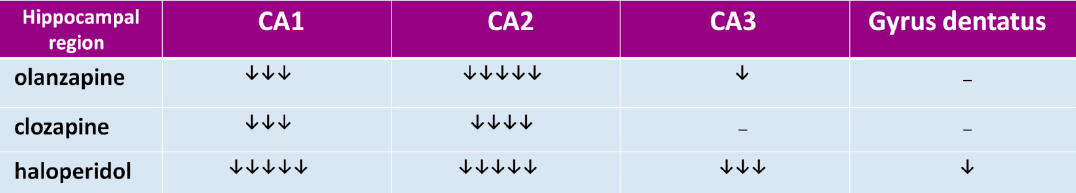
Figure 3. The influence of chronic antipsychotic drug administration on glutamatergic activity in CA1, CA2, and CA3 hippocampus regions and in gyrus dentatus in rats. A number of arrows indicate the neuroleptic’s potential to decrease the glutamatergic activity, resulting from the summation of NR1 expression, and proportion of NR2A to NR2B expression (an arrow was added when NR2B expression prevailed, and subtracted when NR2A expression prevailed).